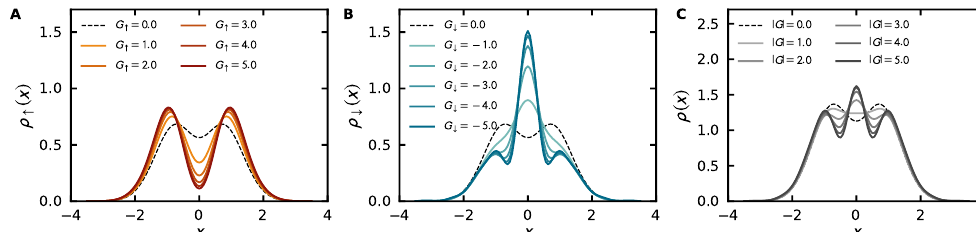
Figure 6: Density profiles. The figure illustrates the density profiles for the 2 ↑ + 2 ↓ system without fermion-fermion interactions (i.e., with g = 0) for representative values of G , see the legend. (A) Density of spin-up particles, ρ ↑ . (B) Density of spin- down particles, ρ ↓ . (C) Total density, ρ = ρ ↑ + ρ ↓ . In all panels the black dashed line corresponds to non-interacting fermions without an